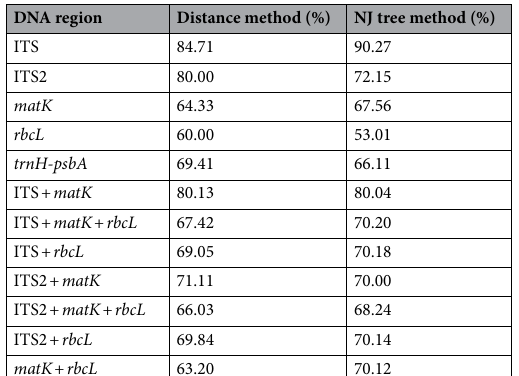
Table 3. Identification success rates obtained using Distance and NJ tree methods for the five single markers and seven combinations.